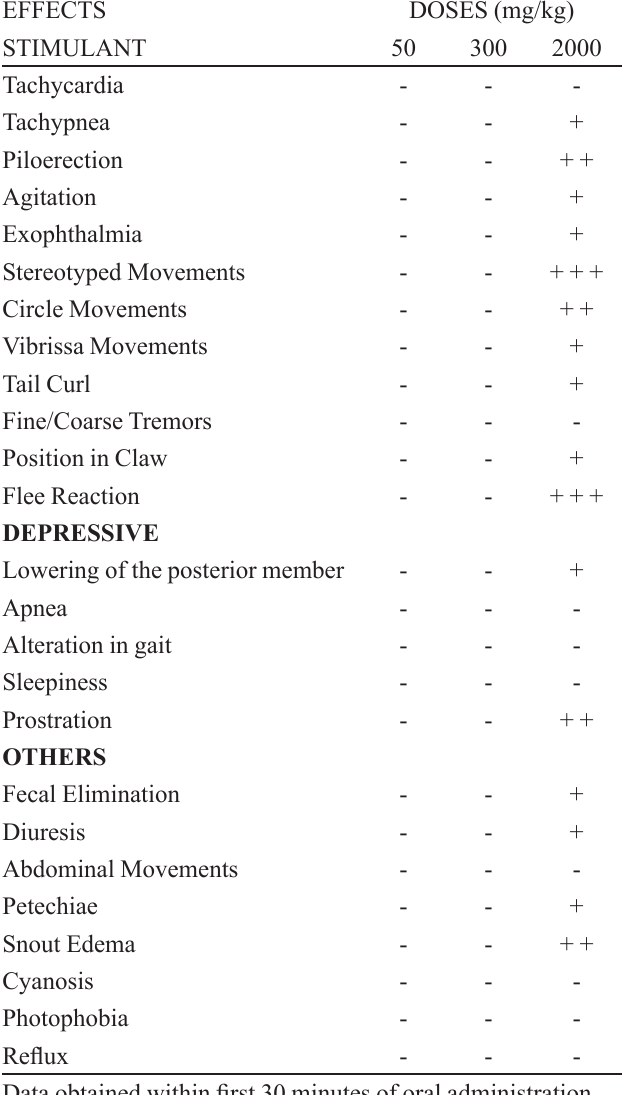
TABLE I – Toxic effects for methanolic extract from H. drasticus leaves in male Swiss albino mice ( Mus musculus )